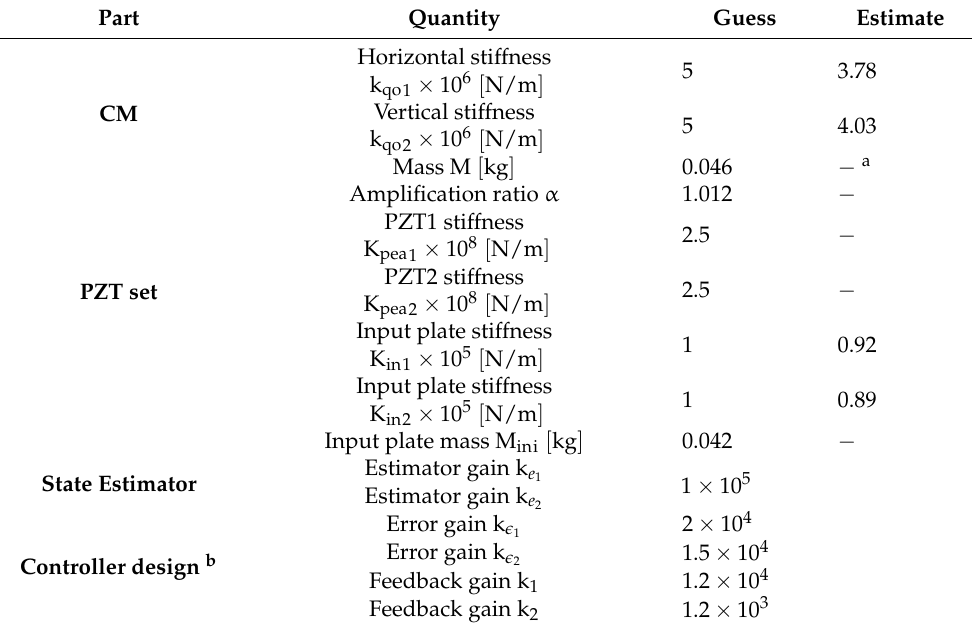
Table 4. Evaluated system parameters and controller design specifications.